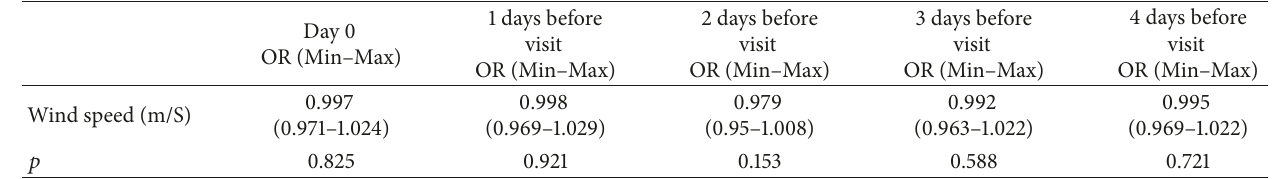
Table 9: Wind speed for 4 days before visit due to